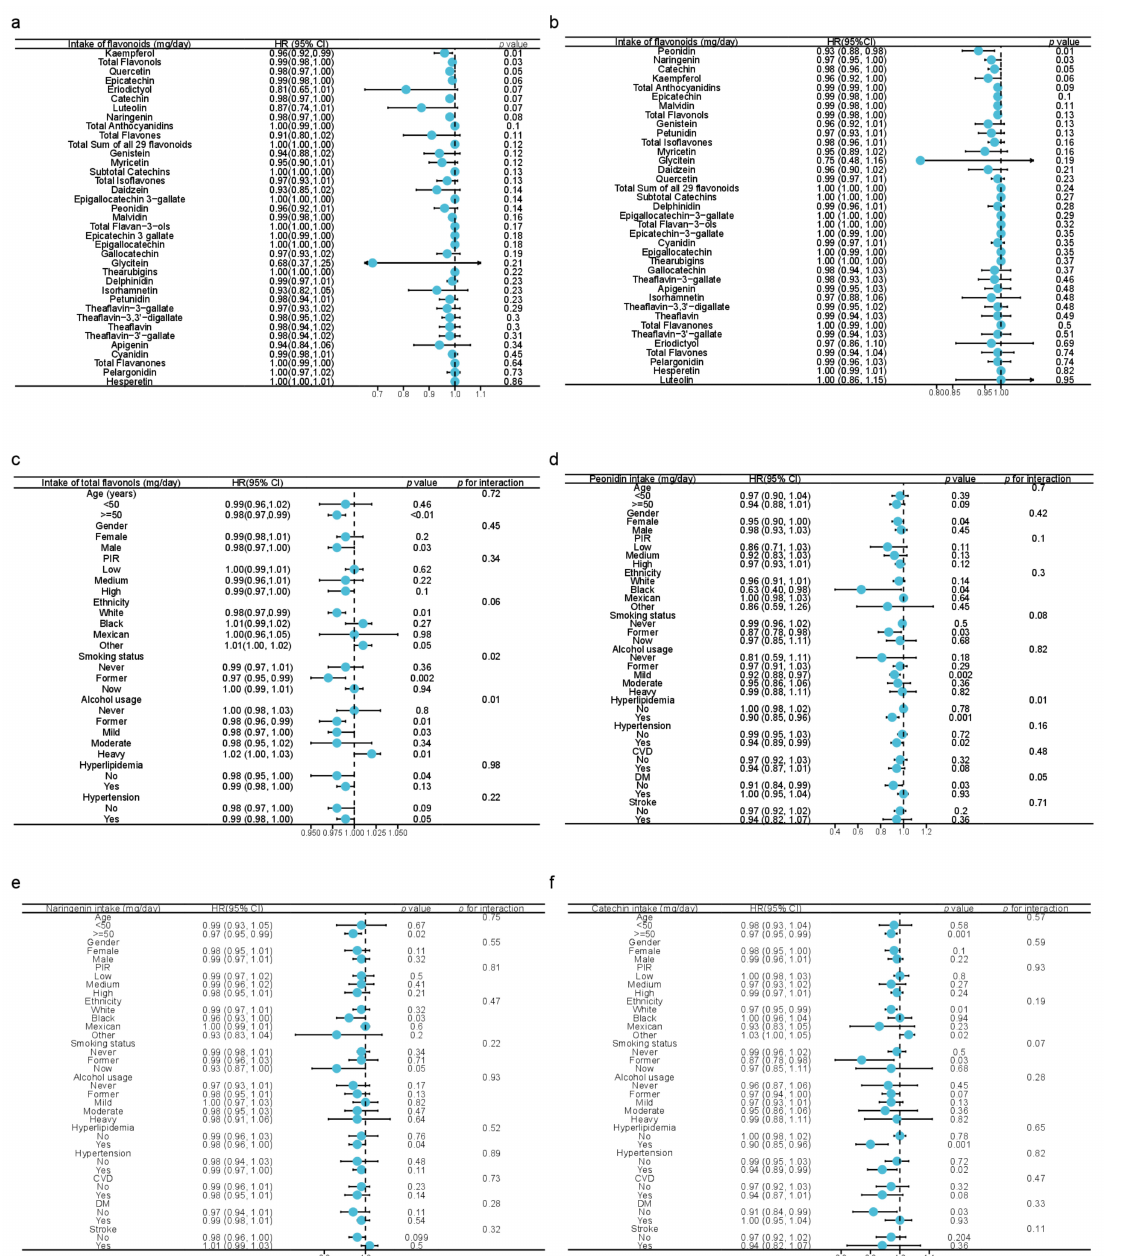
Figure 2. Forest plots in the upper panel display the association between dietary flavonoid intake and cancer-related mortality using univariate ( a ) and multivariate ( b ) analyses adjusted for age, ethnicity, gender, PIR, educational status, marital status, daily energy intake, alcohol consumption, smoking status, cancer history, a total score of HEI, DII, and a total time of PA. ( c ) Forest plot showing the association between cancer-related mortality and total dietary flavonol intake using unadjusted Cox analysis stratified by age, gender, PIR, ethnicity, smoking status, alcohol usage, and disease history. Forest plot showing the association between cancer-related mortality and the dietary intake of peonidin ( d ), naringenin ( e ), and catechin ( f ) using unadjusted Cox analysis stratified by age, gender, smoking status, alcohol usage, and disease history. HR: hazard ratio; PIR: poverty income ratio; HEI: healthy eating index, 2015 version; DII: dietary inflammatory index; PA: physical